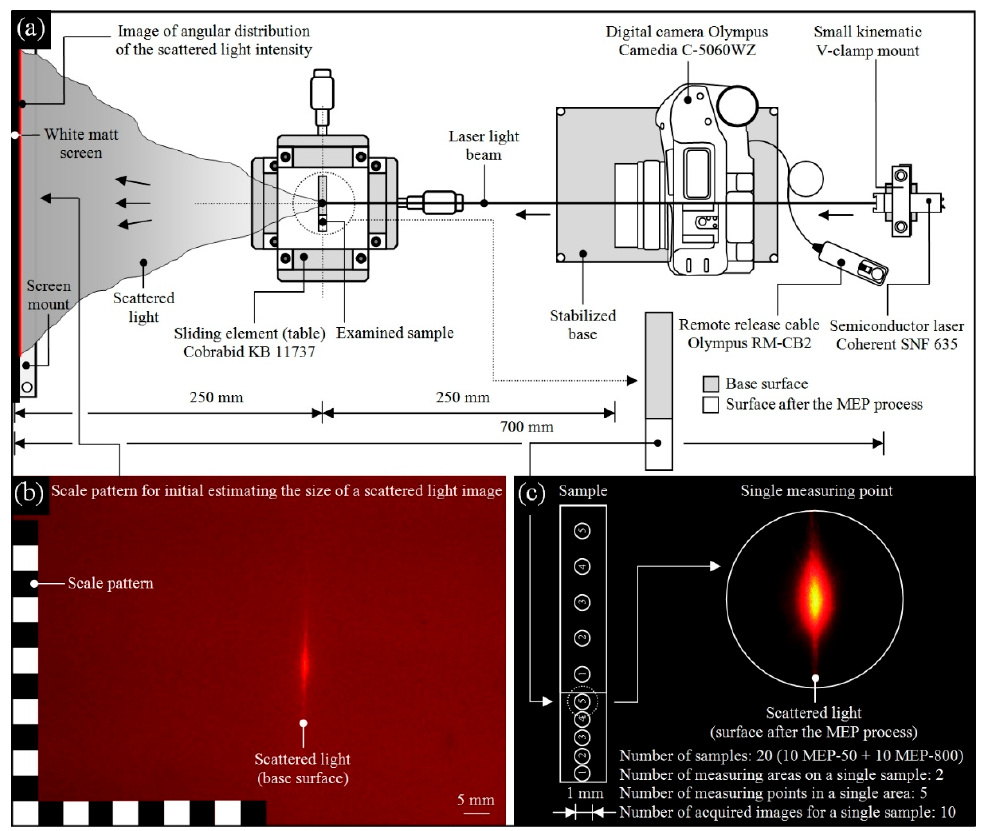
Figure 2. Graphical scheme presenting the experimental setup used for acquisition of digital images of the angular distribution of scattered light intensity: ( a ) general view with key components and the distances between them; ( b ) scale pattern used for initial estimating of scattered light image size; ( c ) methodology of acquisition of scattered light image and main assumptions of acquisition